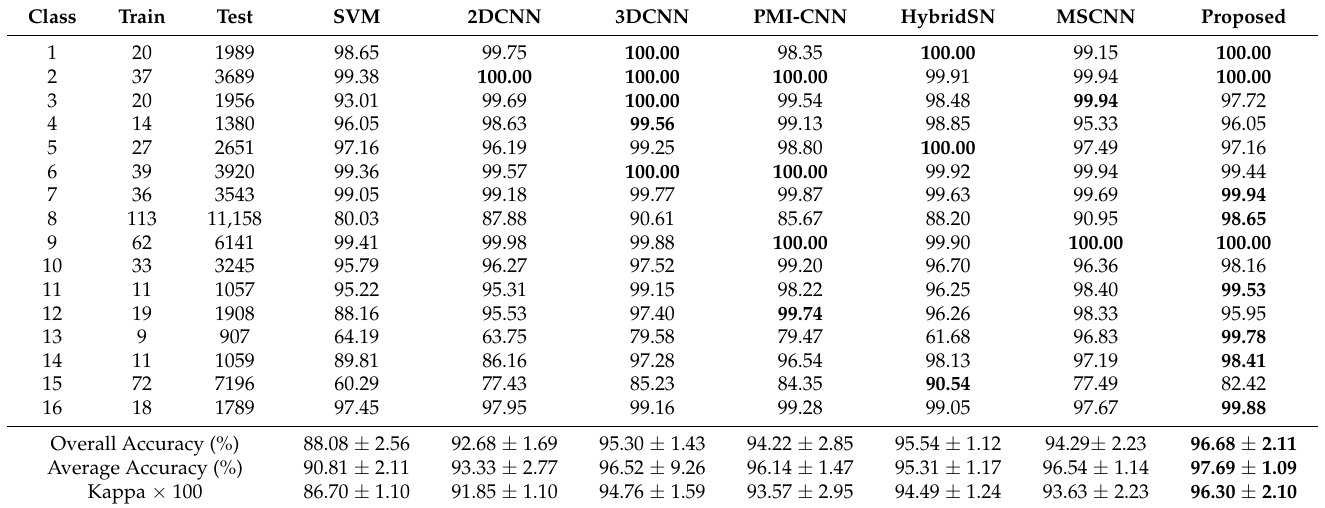
Table 8. Classification results on the SA dataset with 1% labeled training samples. The best accuracy is shown in bold.